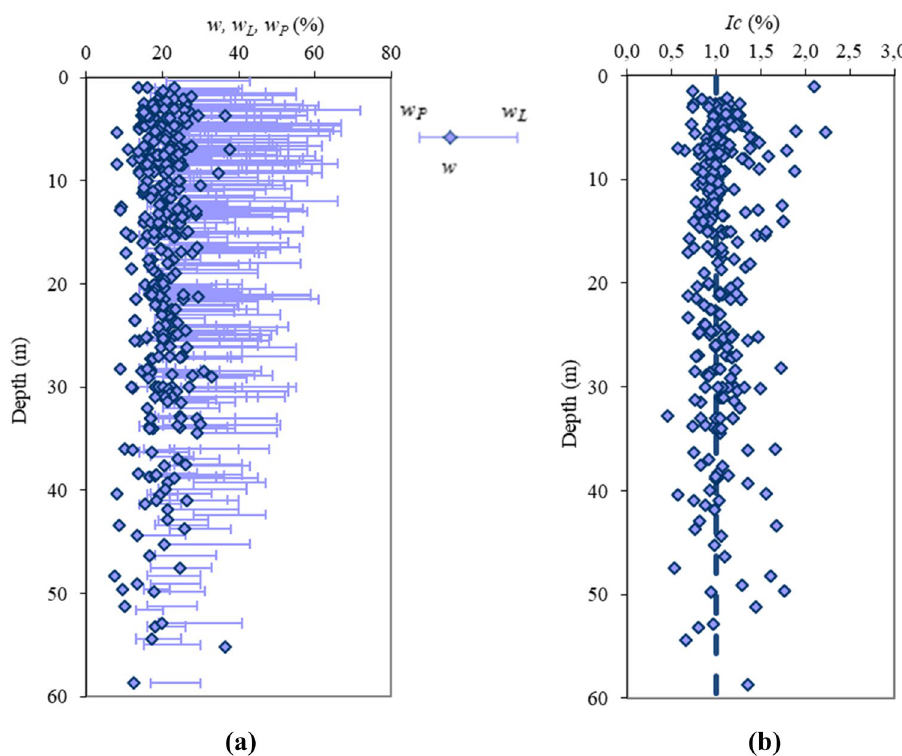
Fig. 2 Prazeres Clay indexes: a Atterberg limits and natural water content; b consistency